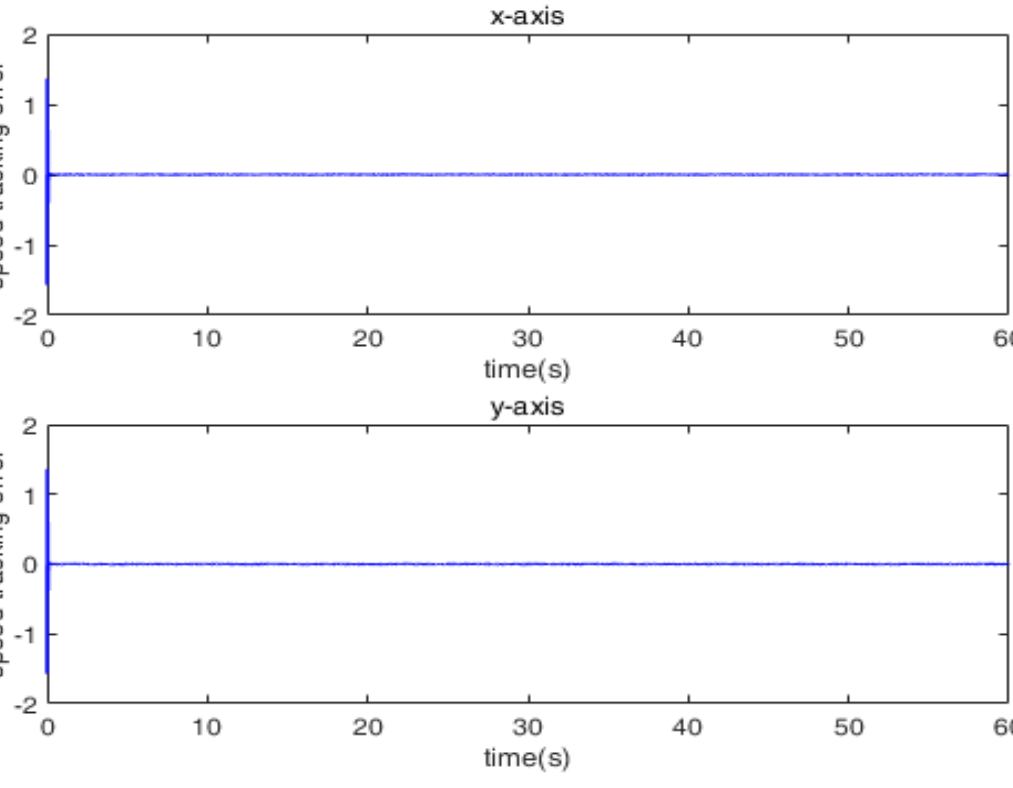
Figure 8. Speed tracking error under NFTSMC ‐ GRFNN.